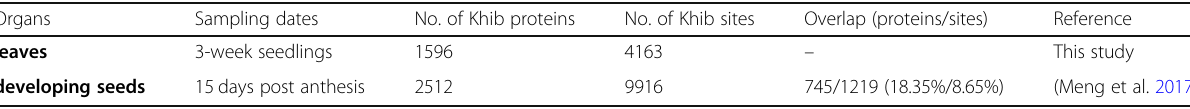
Table 2 Overlapped Khib sites and proteins between rice seedling leaves and developing seeds